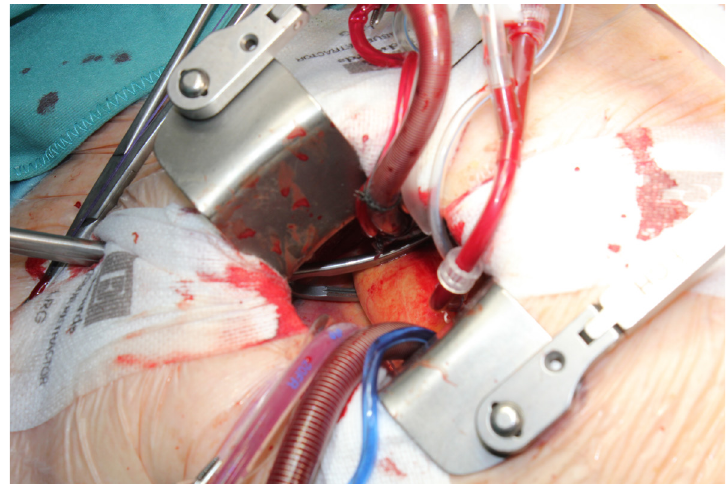
Fig. 6 – Aortic cross-clamping with a Chitwood- DeBakey clamp.